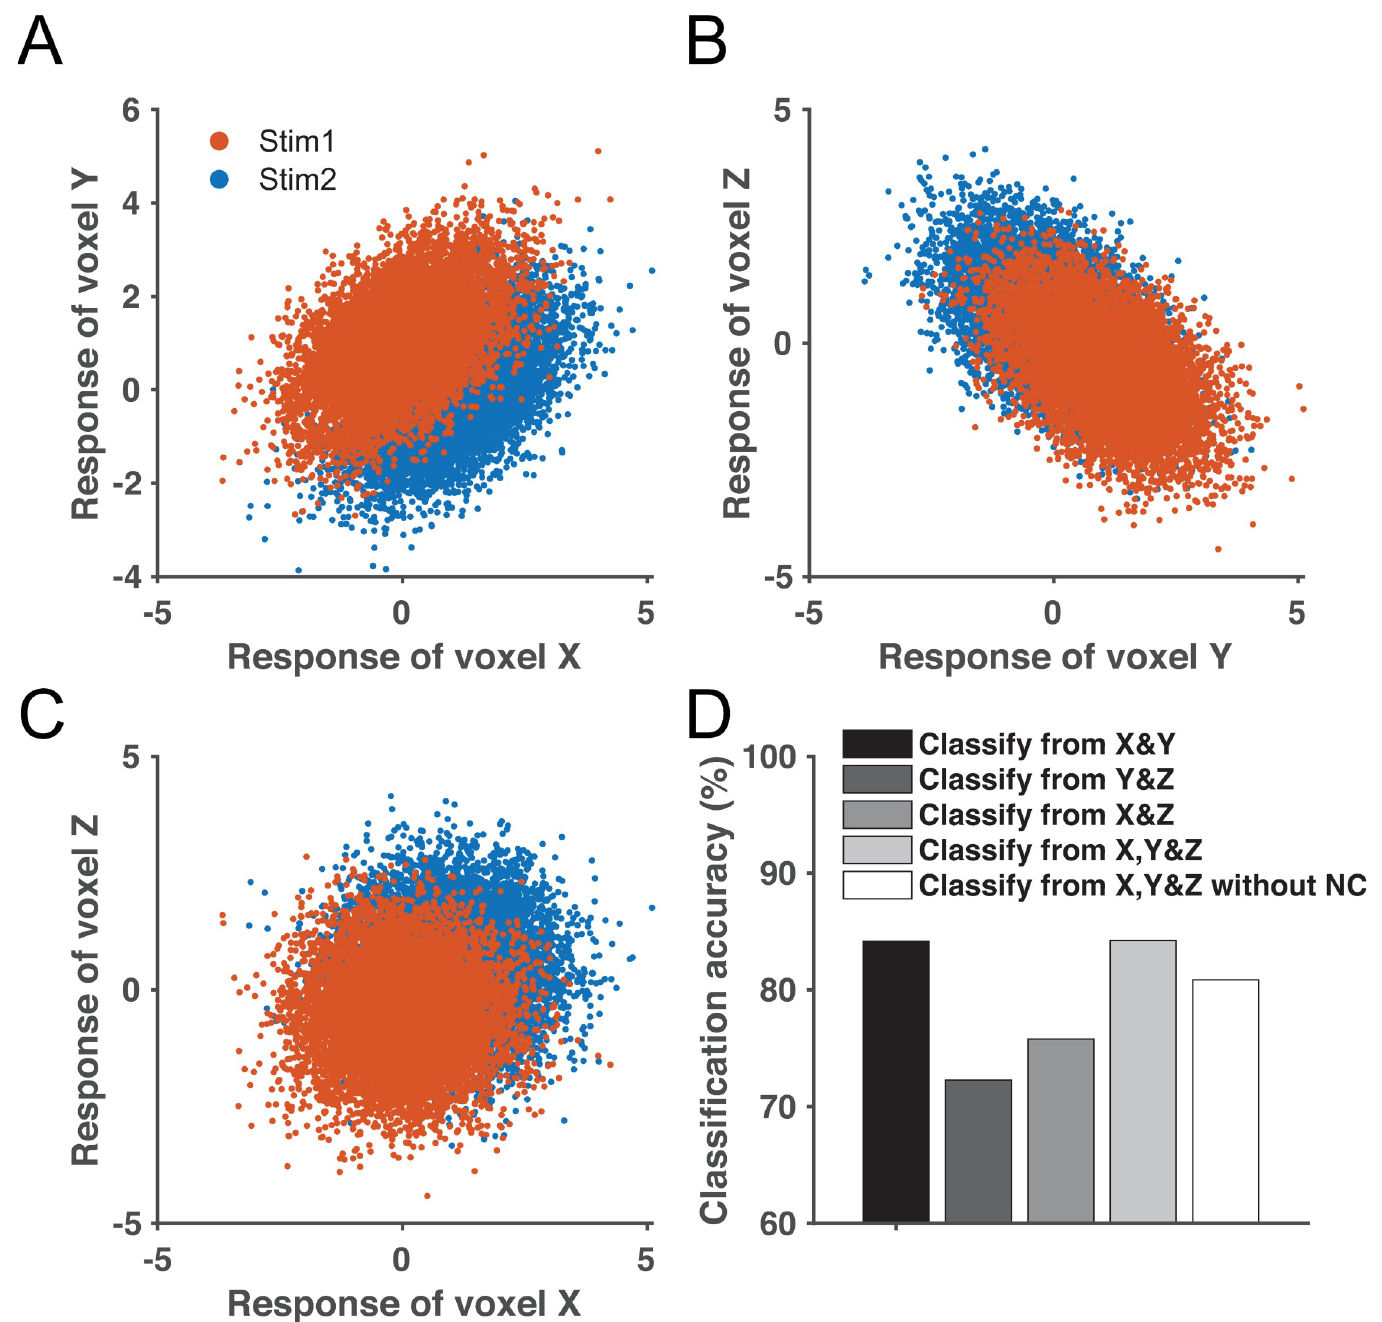
Fig 11. A three-voxel simulation illustrating the disproportional benefits of good covariance in multivariate decoding. Panel A illustrates the trial-by-trial responses of voxels X and Y towards two stimuli. The covariance structure of X and Y enhances classification accuracy. Similarly, panel B illustrates that the covariance structure of voxels Y and Z impairs classification. Voxels X and Z have no systematic NC (panel C). Panel D depicts the classification accuracy based on population responses of X and Y, Y and Z, X and Z, and all three units. We also include a situation where we set all NCs among three units to 0 and keep other settings the same (i.e., X, Y&Z